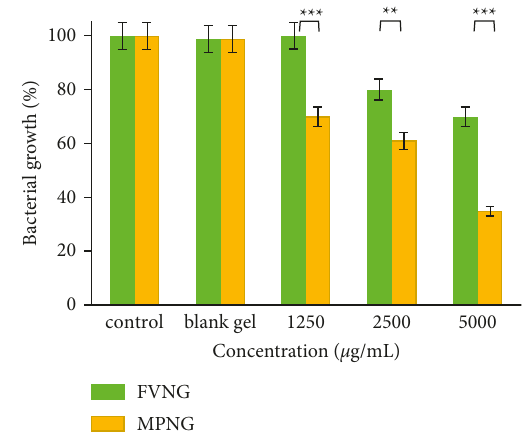
Figure 7: Antibacterial effects of nanogels containing F. vulgare and M. piperita EOs (FVNG and MPNG) and their blank gels (without EO) against S. aureus . The efficacy of MPNG was more potent